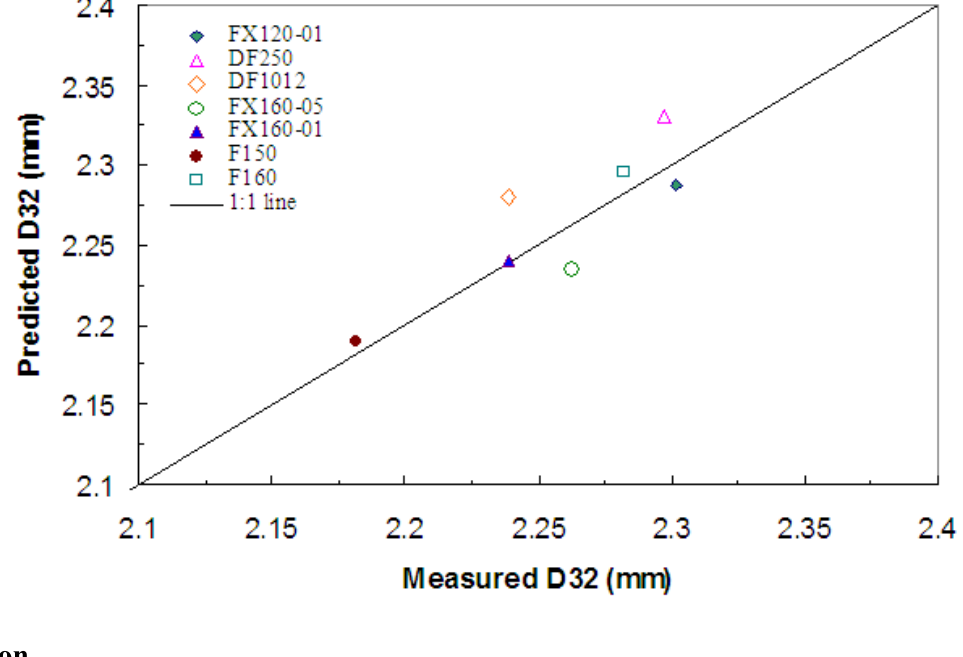
at CCC50 for all commercial 32